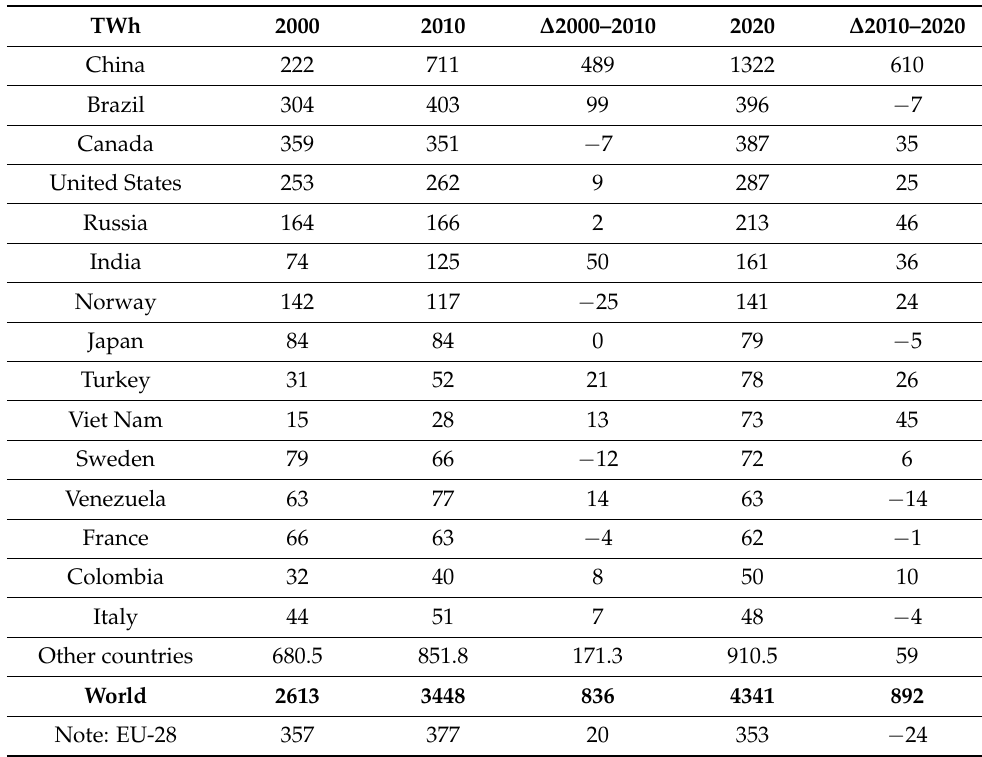
Table 9. Hydropower electricity generation (TWh) (based on [26]).